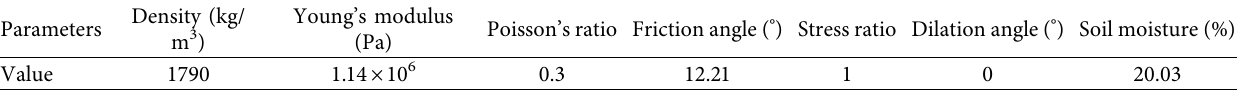
Figure 16: The FDEM simulation model. Table 2: The D-P constitutive model parameters of the soil mass.